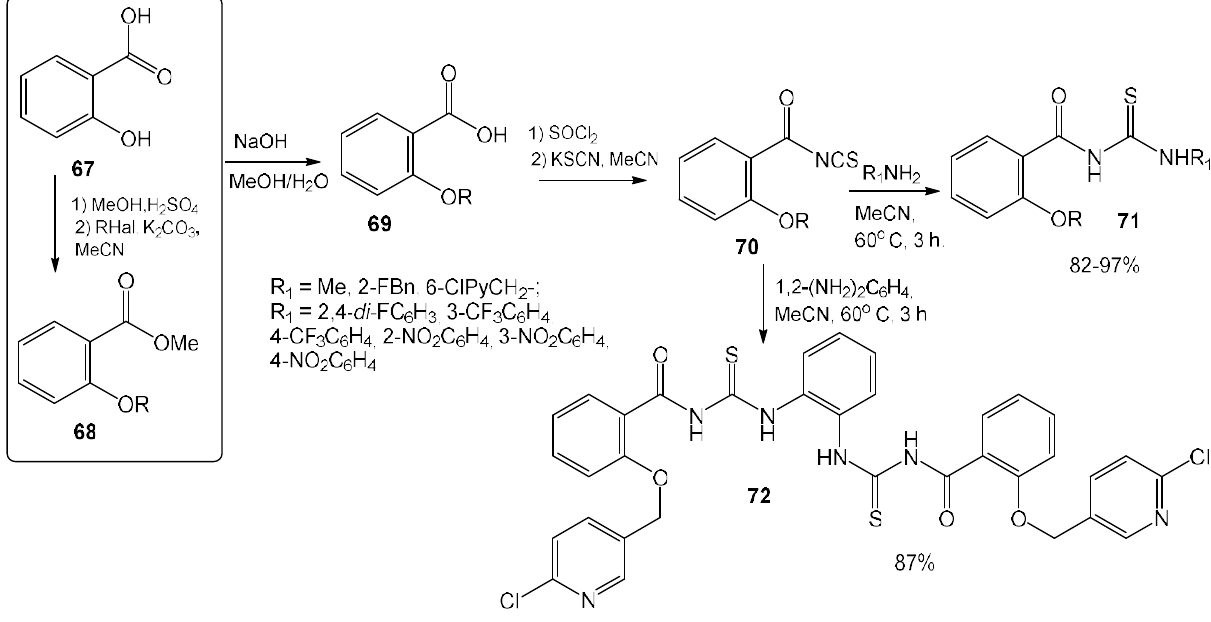
Fig. 20. Synthesis of salicylic acid-oriented thioureas and bis-thioureas